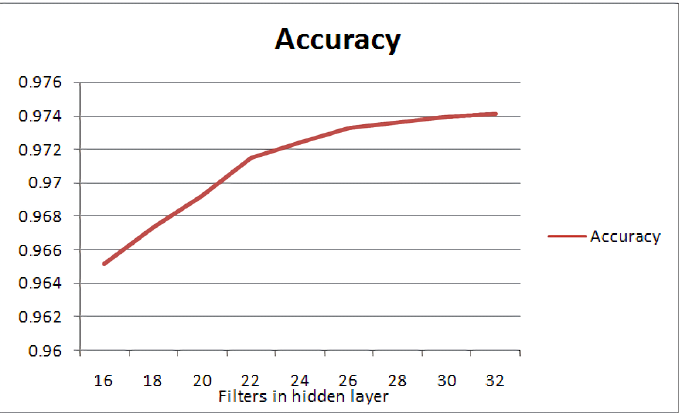
Figure 5. Accuracy diagram for a varying number of filters in the hidden layer of a 1-layer convolutive NN for the MNIST dataset. Table 2. Accuracy values and first-order approximated derivative of accuracy. The slope of the curve reaches a maximum at the configuration of 22 filters, after which it is almost flat. Conv.